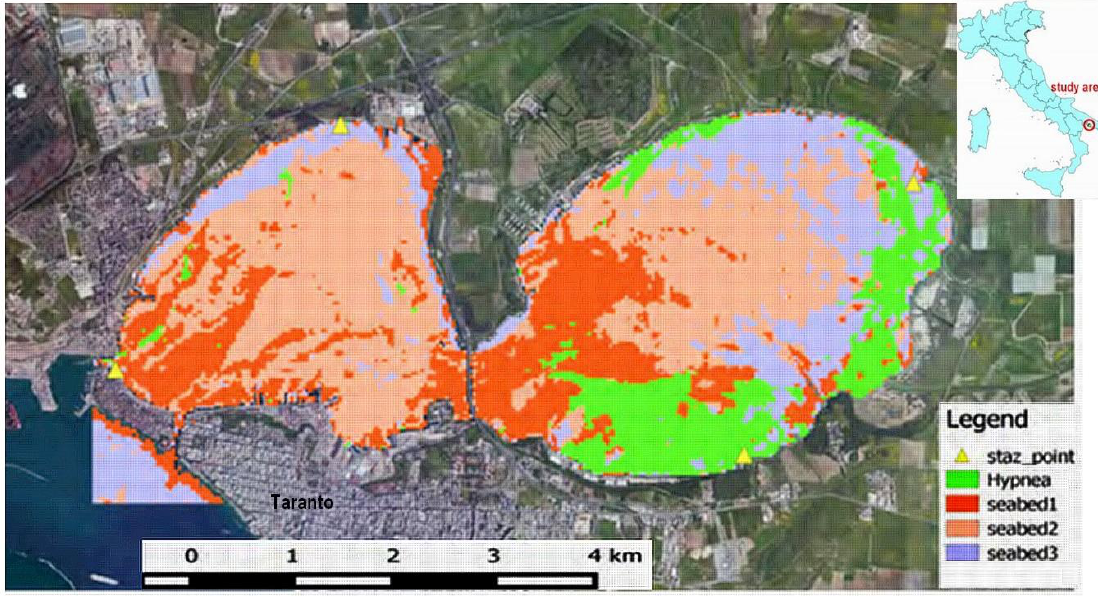
Figure 3. Thematic map of Hypnea cornuta from Landsat 8 Operational Land Imager (OLI) data acquired on August 2014 (from Reference [72]).